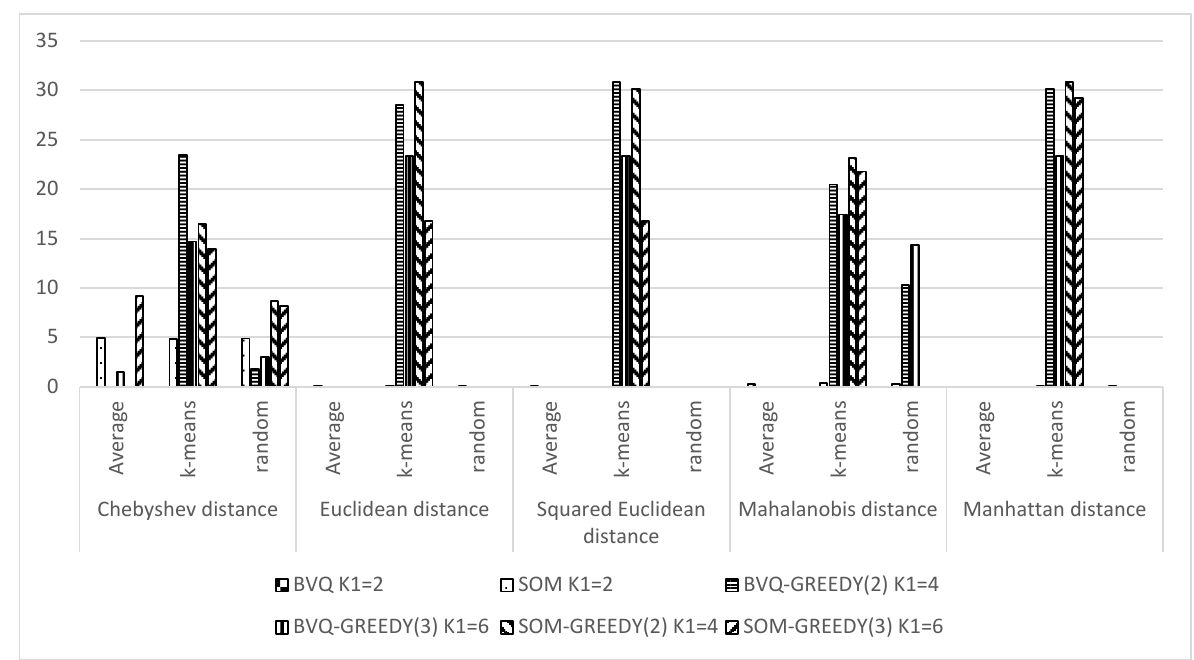
Algorithms 2022 , 15 , x FOR PEER REVIEW Figure 3. Coefficient of variation of the objective function value for the two ‐ batch mixed lot. Figure 3. Coefficient of variation of the objective function value for the two-batch mixed lot.